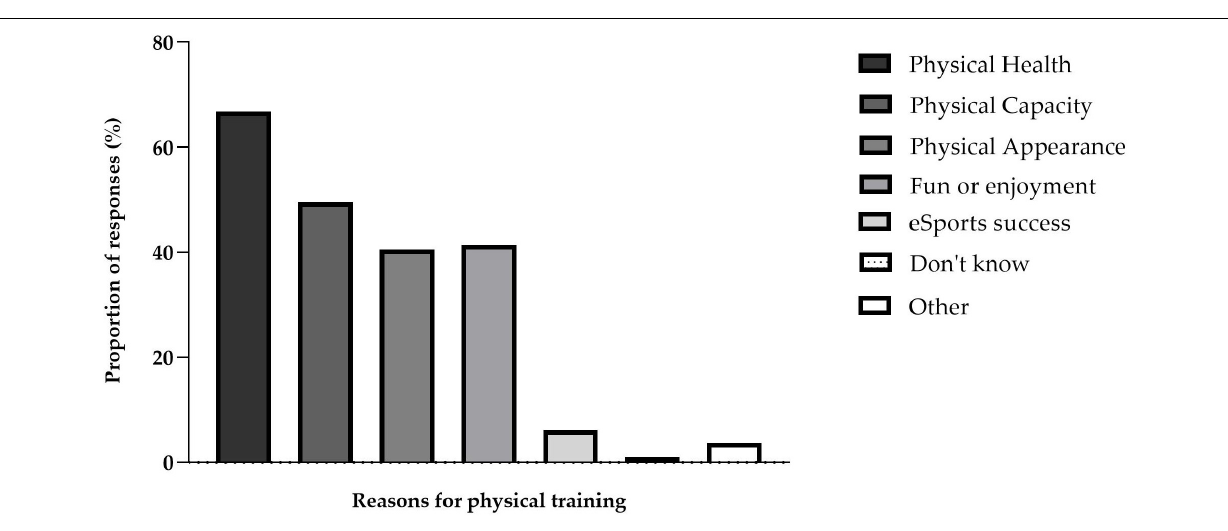
FIGURE 4 | Responses to the question “What is your main reason for doing physical training?”. More than one response was